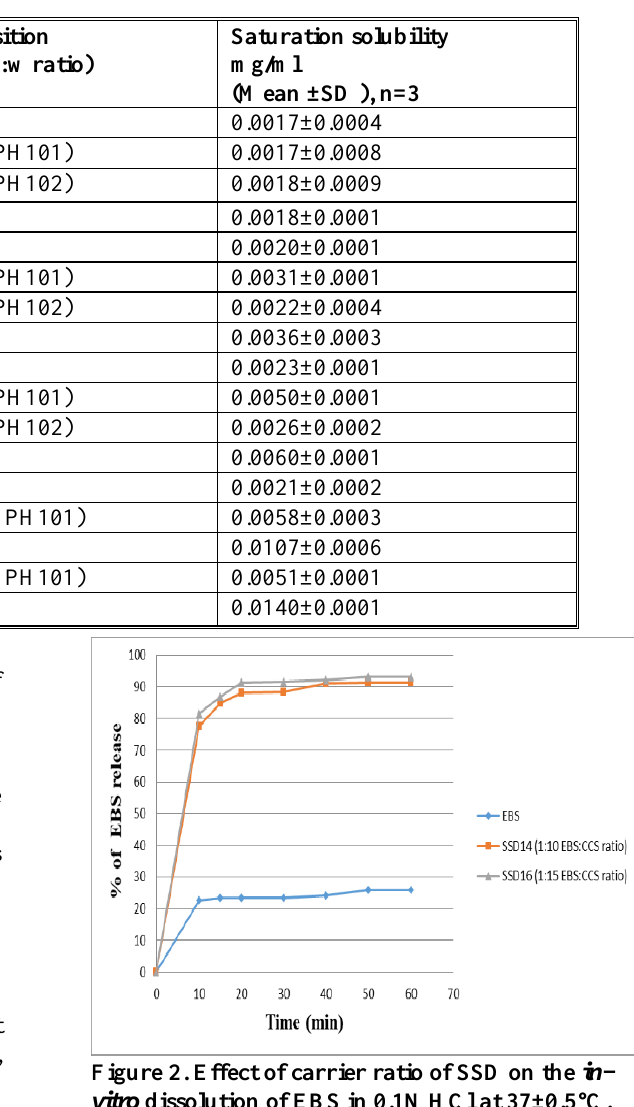
Table 3. The saturated solubility of EBS SSDs prepared with several Drug:Carrier w:w ratios in distilled water at 25 ˚ C.